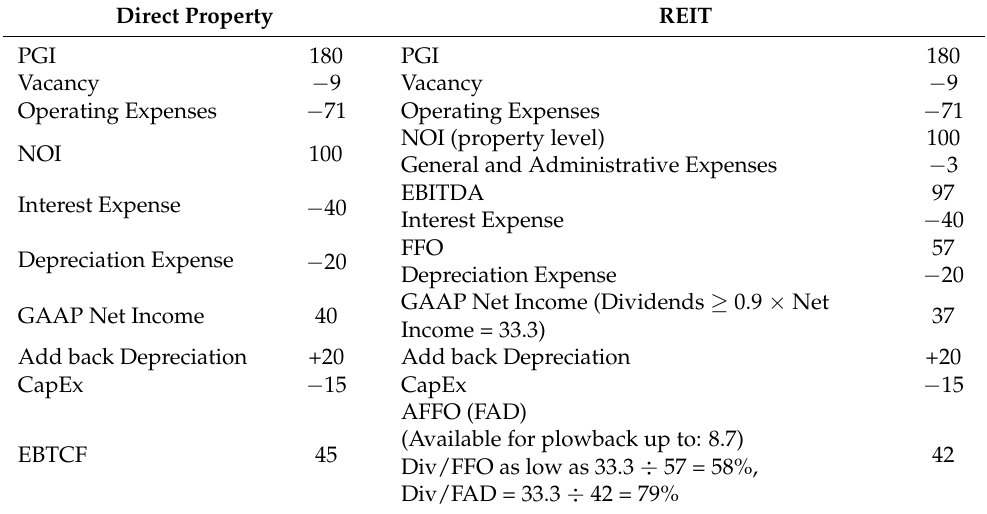
Table 1. Example of REITs Earning